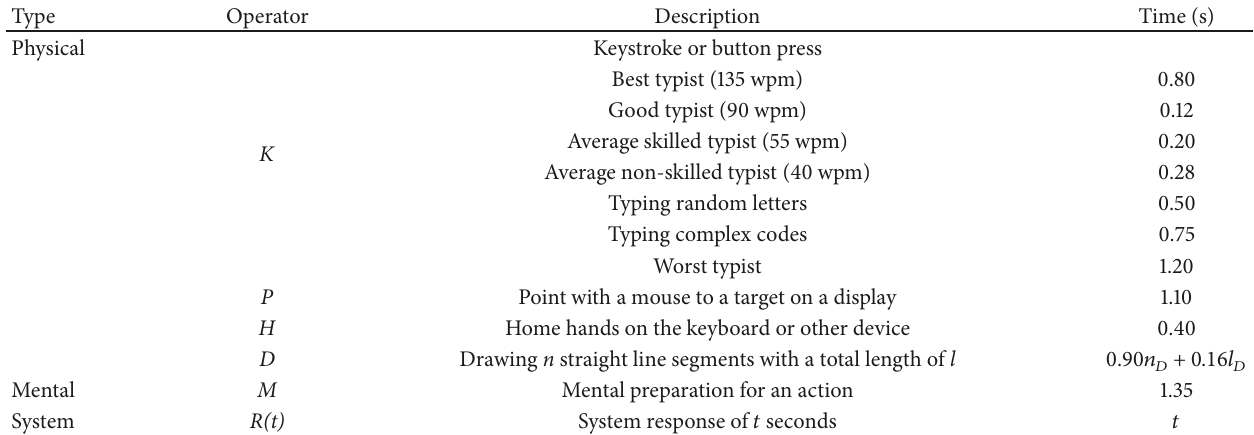
Table 1: KLM operators and predicted execution times in seconds